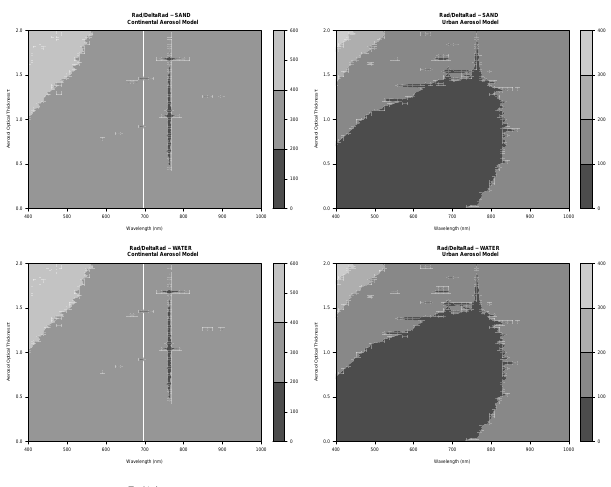
Fig. 6. The L(λ) in the PRISMA observed radiance simulated by 1L(λ) Fig.6. The L ( λ ) ∆ L ( λ ) inthePRISMAobserved radiance simulatedbyincreasingtheaerosolloading, τ a 550 ∈ ∈ { 0 . 00 − 2 . 00 } with 1τ a = increasing the aerosol loading, τ a { 0 . 00 − 2 . 00 } with ∆ τ a 550 =0 . 02 ,forsand(firstrow)andwater(secondrow)incontinental(firstcolumn) 550 550 and urban (second column) aerosol model. 0 . 02, for sand (first row) and water (second row) in continental (first column) and urban (second column) aerosol